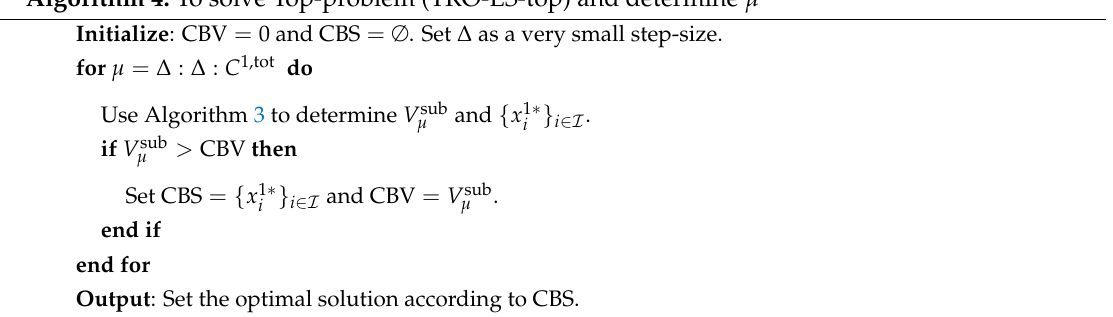
Algorithm 4: To solve Top-problem (TRO-ES-top) and determine µ